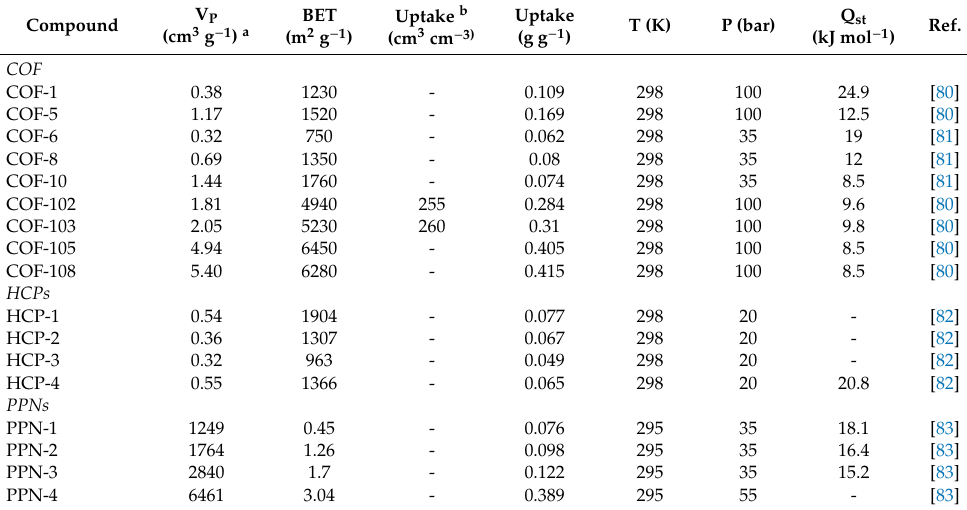
Table 2. Pore volume, methane uptake, and methane deliverable capacity of selected porous organic polymers [4].